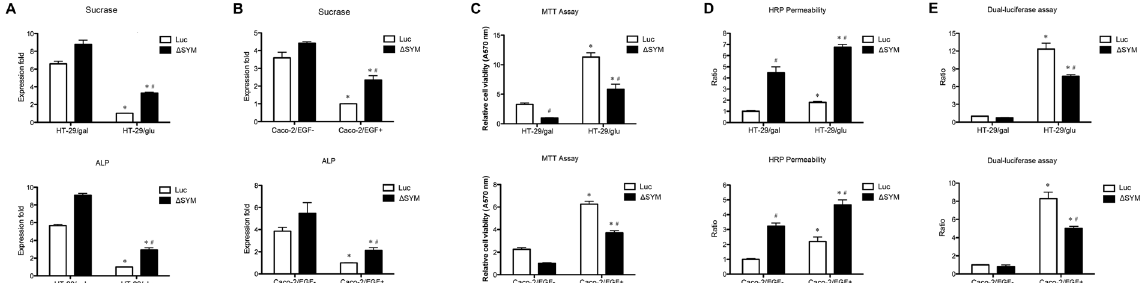
Figure 2. Cellular effects induced by the nuclear accumulation of symplekin. ( A , B ) qRT-PCR validation for sucrase and ALP in HT-29 and Caco-2 cells with the indicated treatments. Knockdown of symplekin ( Δ SYM) and control (Luc) were also included. MTT assay ( C ) and dual-luciferase assay for Topflash activity ( E ) in HT-29 and Caco-2 cells with the indicated treatments. ( D ) Cell monolayer integrity assessment. The lower chamber medium was collected after 30 min/12 hr permeation for treated HT-29/Caco-2 cells, respectively. Data was analyzed using one-way ANOVA and Student’s t-test. * P < 0.05 versus corresponding differentiation cultured cells. # P < 0.05 versus corresponding RNAi control cells. Values are means ± SEM (n =